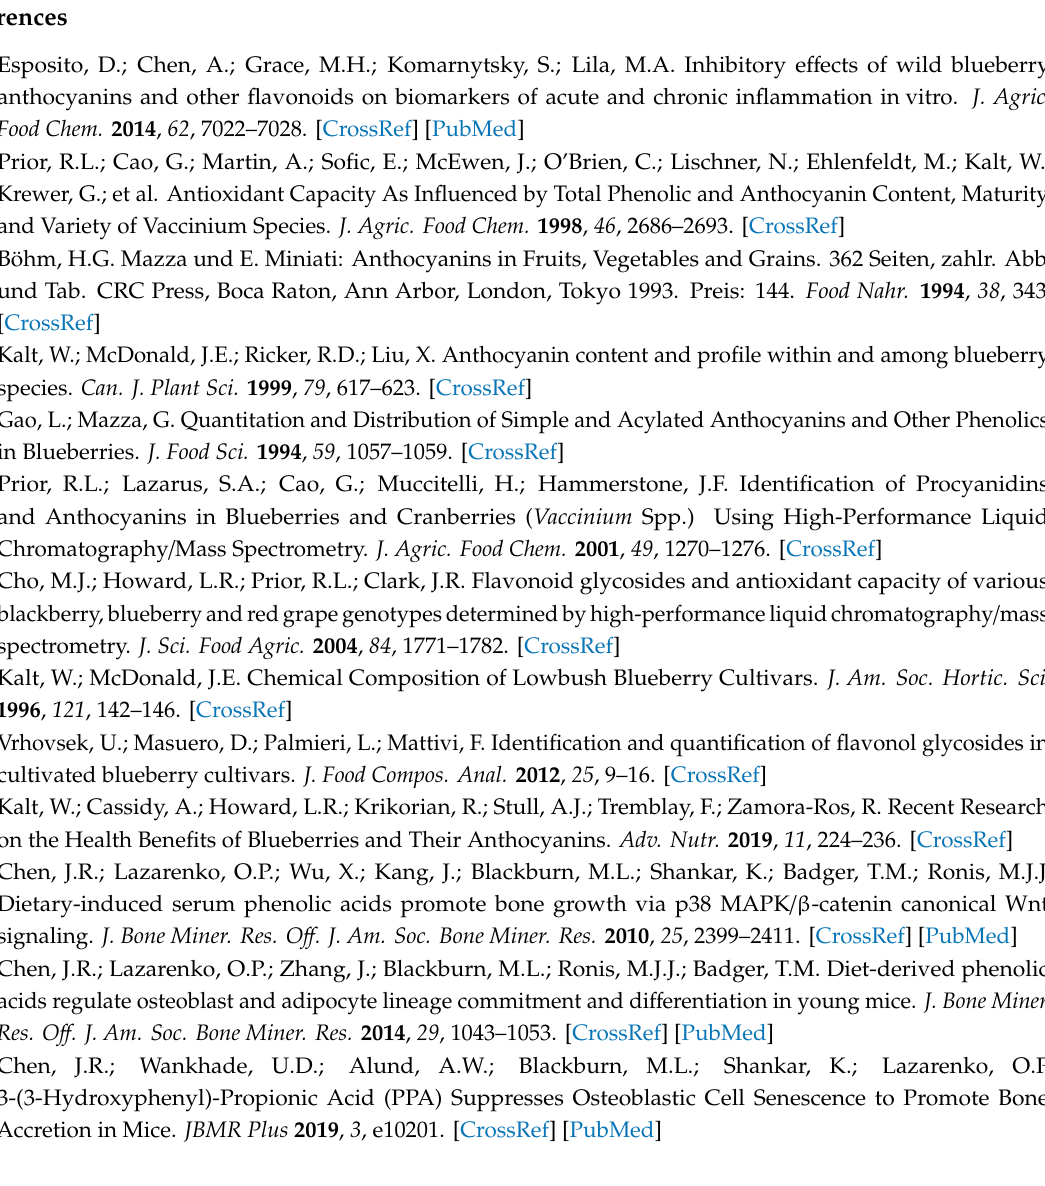
Pnd = peonidin, Ptd = petunidin. Sugar moiety: ara = arabinoside, gal = galactose, glc = glucose. Figure S3: Individual anthocyanin content of blueberry graham cracker cookie stored at 4.4 and 21 ◦ C over eight weeks. Bars represent standard error of the mean ( n = 3 / time point). Anthocyanidins: Cyd = cyanidin, Dpd = delphinidin, Mvd = malvidin, Pnd = peonidin, Ptd = petunidin. Sugar moiety: ara = arabinoside, gal = galactose, glc = glucose. Figure S4: Individual anthocyanin content of blueberry juice stored at 4.4 and 21 ◦ C over eight weeks. Bars represent standarderrorofthemean( n = 3 / timepoint). Anthocyanidins: Cyd = cyanidin, Dpd = delphinidin, Mvd = malvidin, Pnd = peonidin, Ptd = petunidin. Sugar moiety: ara = arabinoside, gal = galactose, glc = glucose. Figure S5: Individual anthocyanin content of blueberry gummy stored at 4.4 and 21 ◦ C over eight weeks. Bars represent standarderrorofthemean( n = 3 / timepoint). Anthocyanidins: Cyd = cyanidin, Dpd = delphinidin, Mvd = malvidin, Pnd = peonidin, Ptd = petunidin. Sugar moiety: ara = arabinoside, gal = galactose, glc =